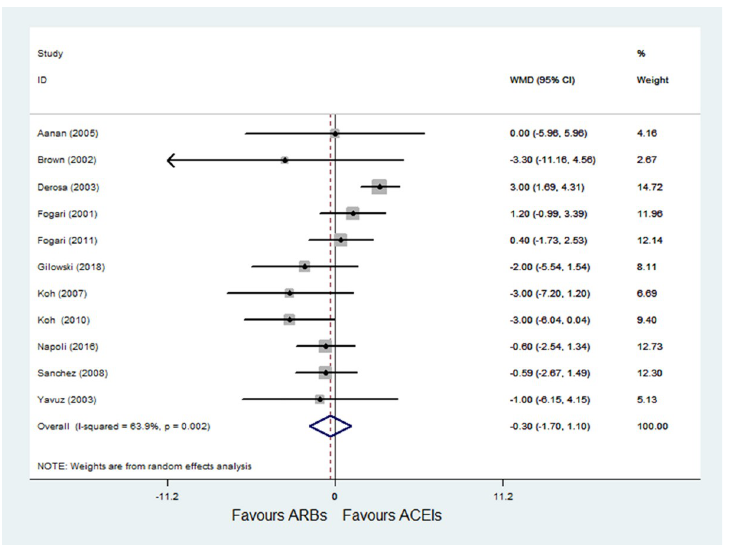
Fig 7. Effect of ARBs versus ACE inhibitors on diastolic blood pressure.